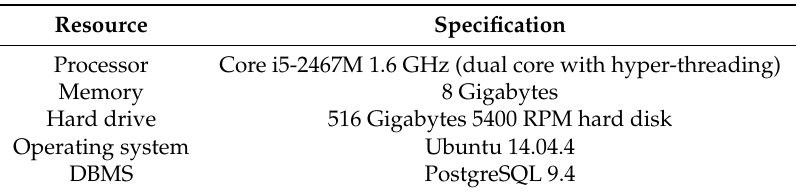
Table 12. Equipment used in